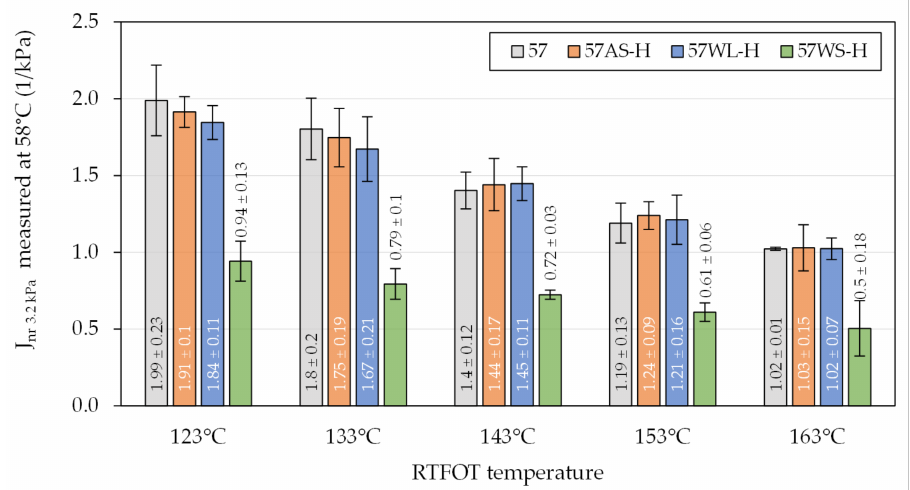
Figure 10. Non-recoverable creep compliance of the investigated asphalt binders based on the 50/70-penetration bitumen evaluated in the MSCR